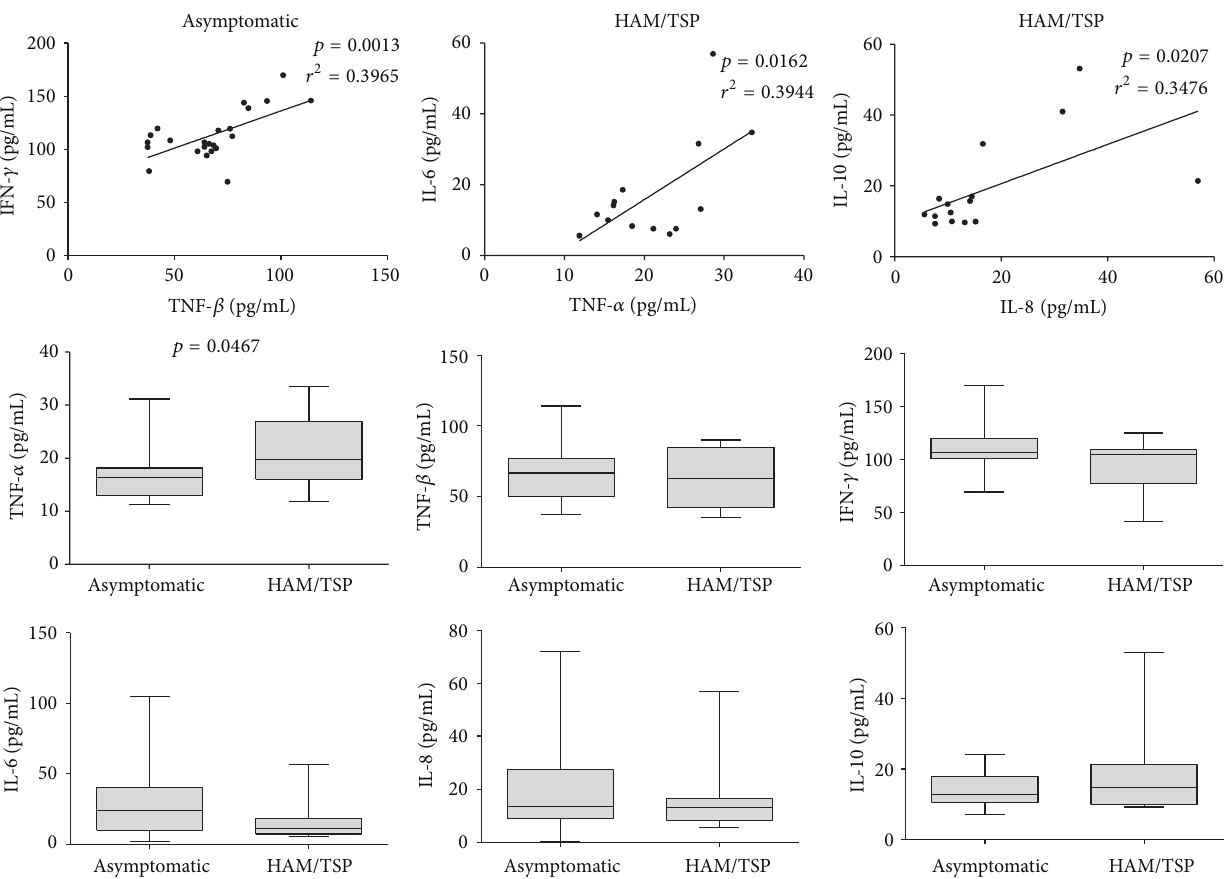
Figure 2: Comparison and correlation of the cytokine serum levels in the HAM/TSP and asymptomatic groups.